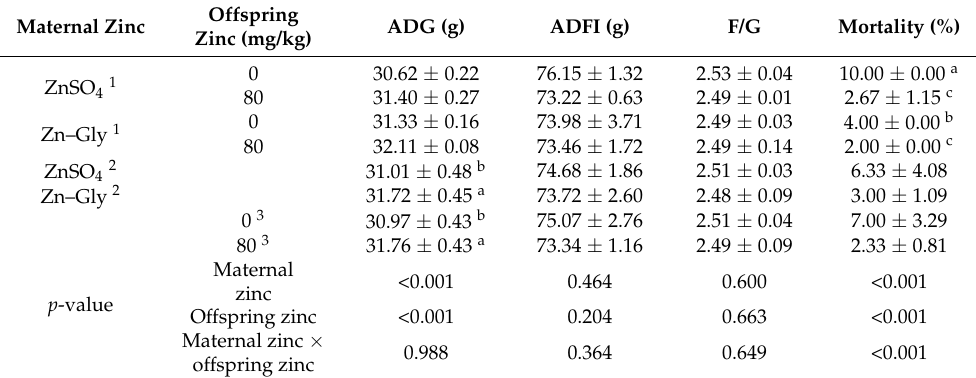
Table 3. Effects of maternal Zn in conjunction with their offspring dietary Zn supplementation on growth performance of day 1–60 in offspring broilers (mean ±